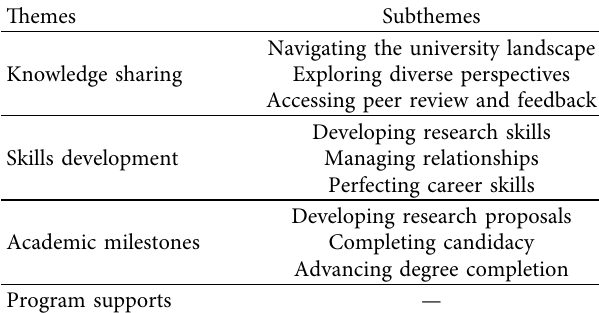
Table 1: Impact of peer mentorship